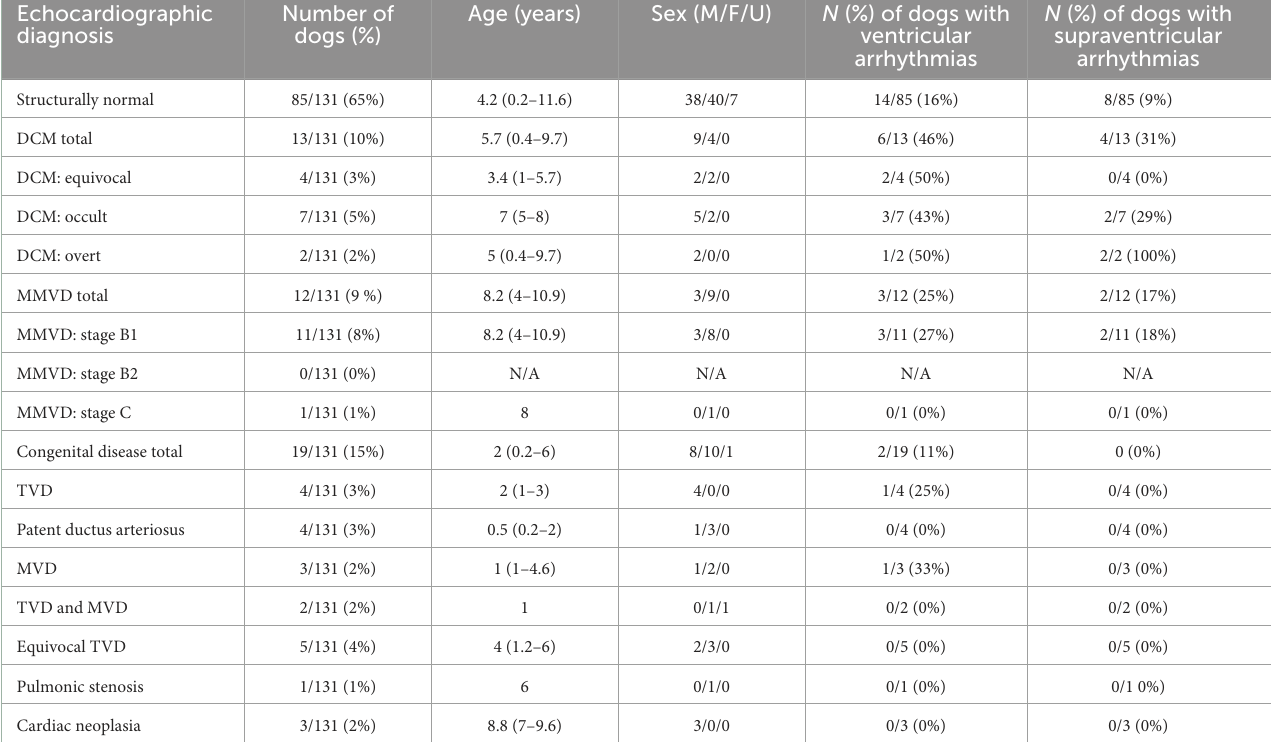
TABLE 2 Demographic and arrhythmia frequency data in 131 Borzoi, separated by echocardiographic diagnosis. Echocardiographic Number of diagnosis dogs (%)